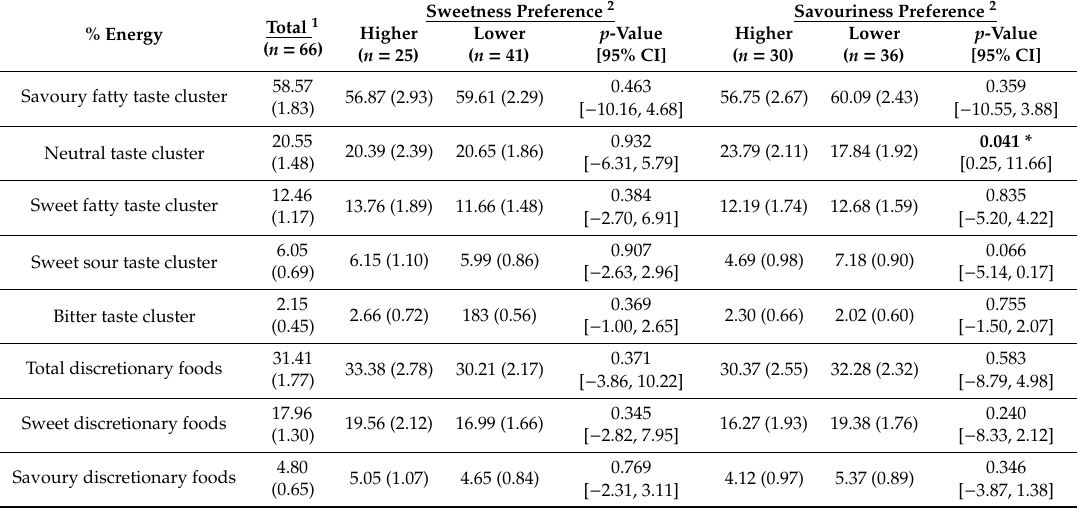
Table 3. Associations between sweetness and savouriness preferences with proportion of energy intake (% energy) from taste clusters and discretionary foods ( n =